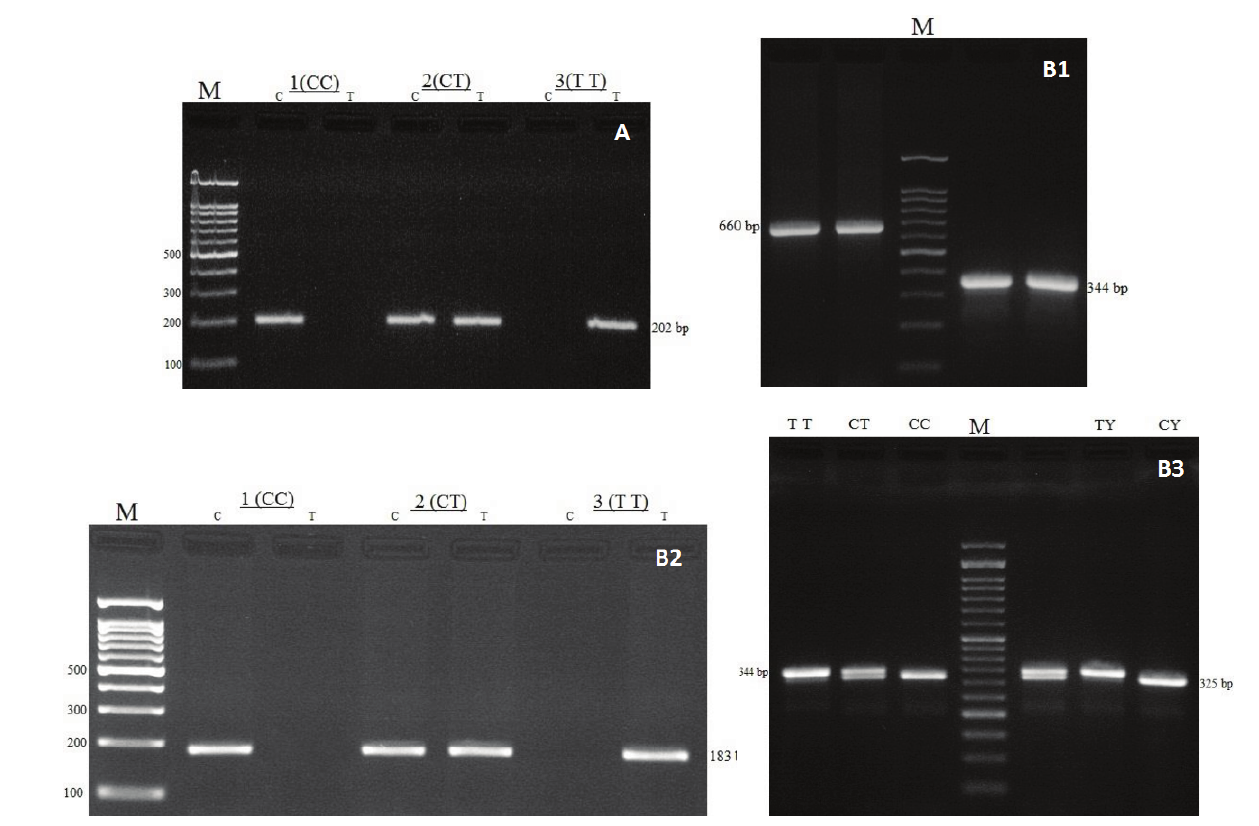
Figure 1. Electrophoresis pattern for the detection of SNPs in COL4A4 rs2228557 and TIMP-1 rs4898. (A) Arms-PCR products of COL4A4 rs2228557, M: DNA marker (100 bp). (B1) TIMP-1 rs4898, Nested-PCR products, M: DNA marker (100bp), product size (660 and 344bp), respectively. (B2) ARMS-PCR products, product size (202bp), (TT, TC, CC) demonstrate genotypes. (B3) RFLP-PCR products, M: DNA marker (50bp), product sizes were 344bp for TT, 344bp and 325bp for TC, 325bp for CC in female, 344bp for TY and 325bp for CY in male, (TT, TC, CC) demonstrate female and (TT = TY, CC = CY) demonstrate male genotypes, (Y stands for the Y-chromosome).